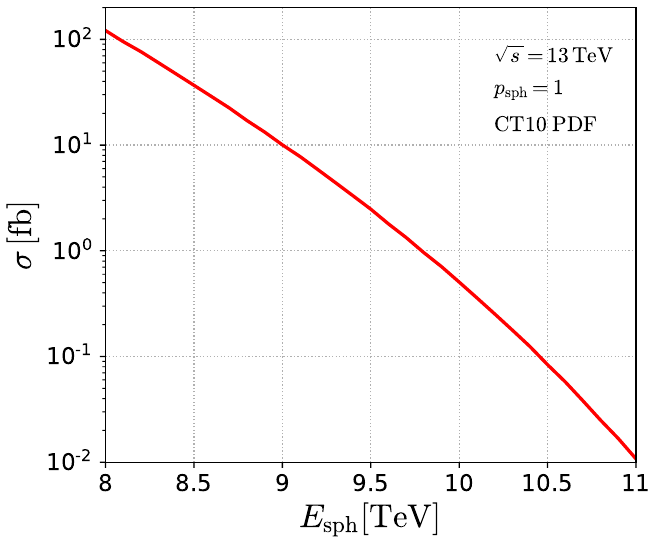
Figure 3 . The 13 TeV inclusive hadronic cross-section for sphaleron production with p sph = 1 as a function of E sph in eq. (2.1), obtained with the CT10 LO PDF set.